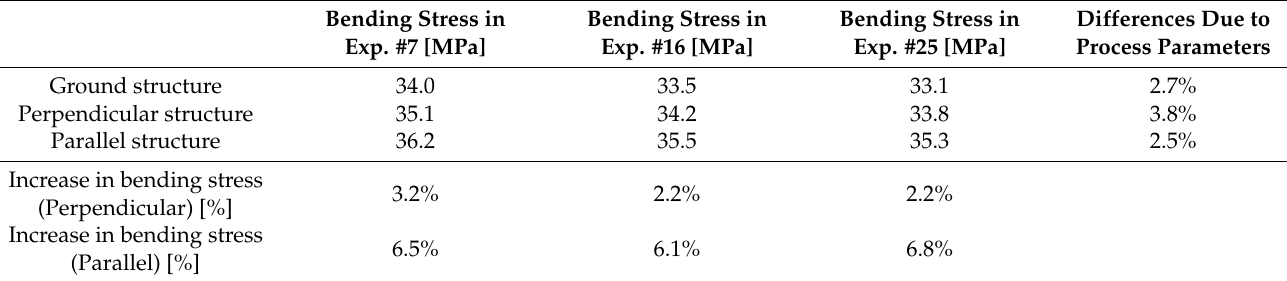
Table 9. The values of the bending stress in three experiments and the percentage of increase in structured specimens.